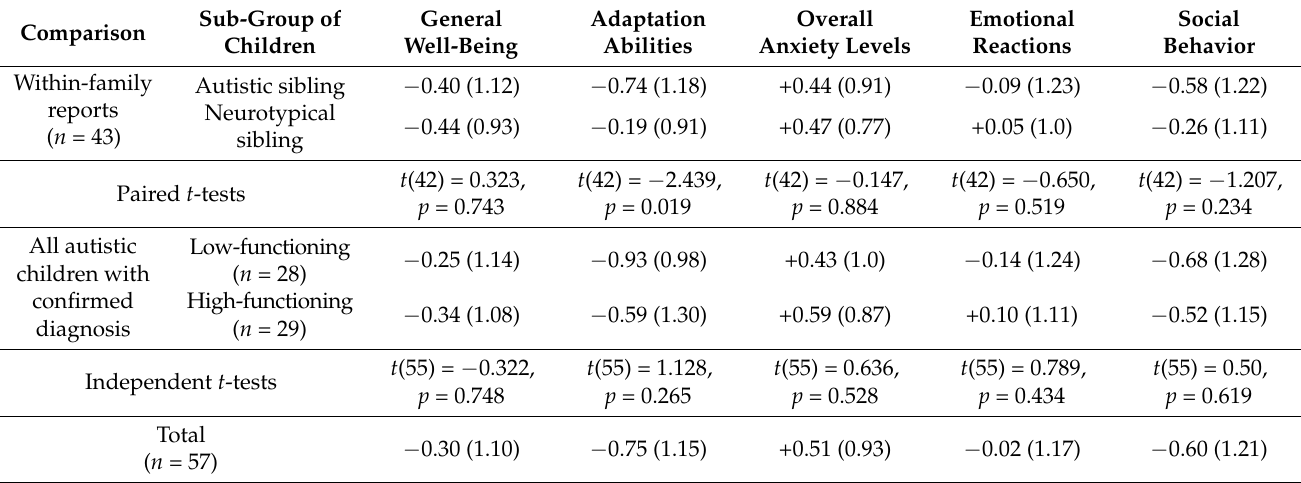
Table 1. Overview of mean changes in quality of life and functional abilities, compared to the time before the pandemic (SD in